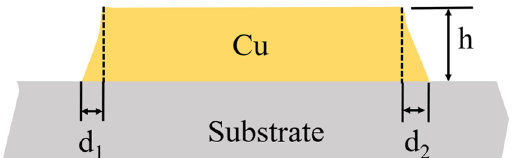
Figure 10: Representation of parameters for calculating the etching